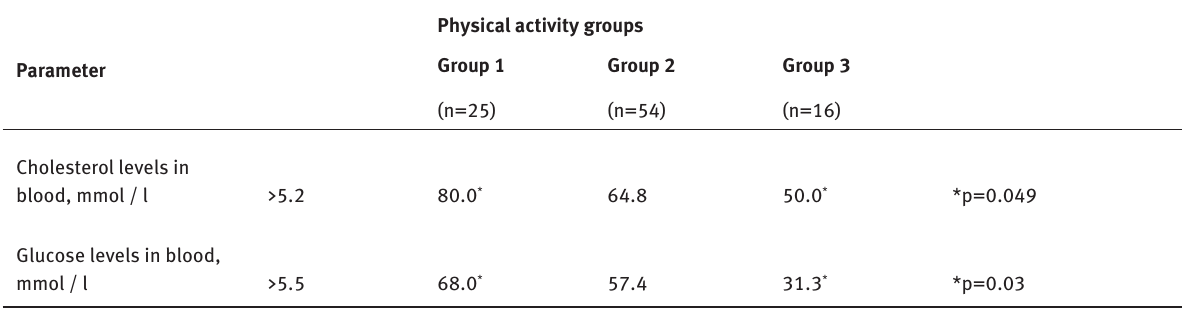
Table 1: Comparison of subjects’ cholesterol and blood glucose levels according to their physical activity